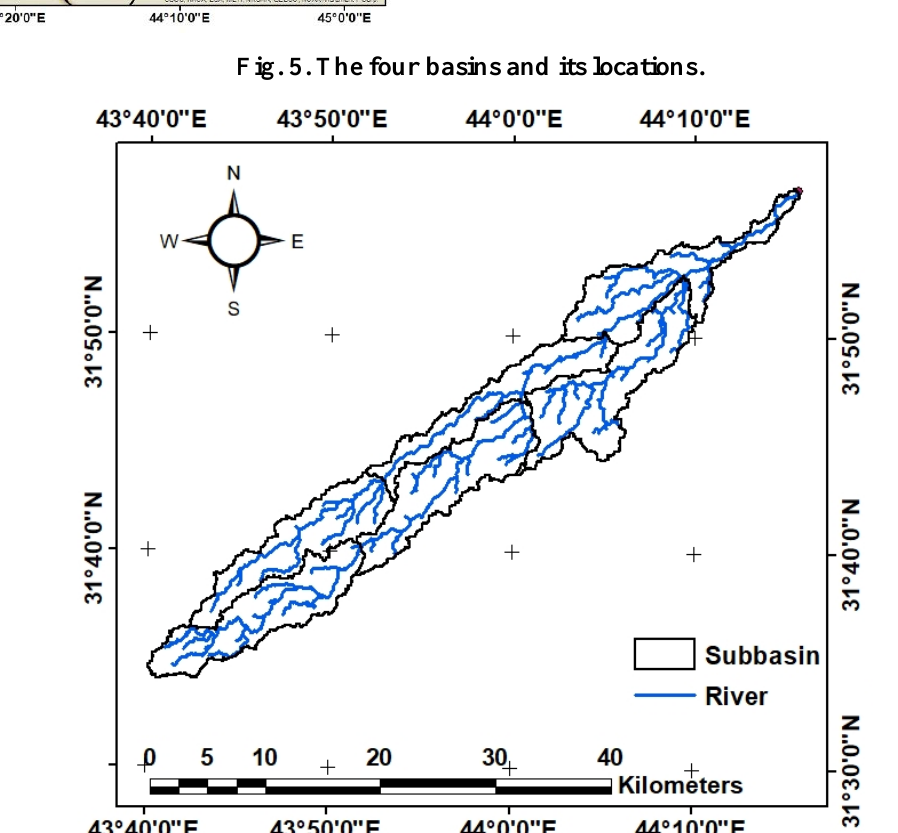
Fig. 6. The distributary's streams of the basin1